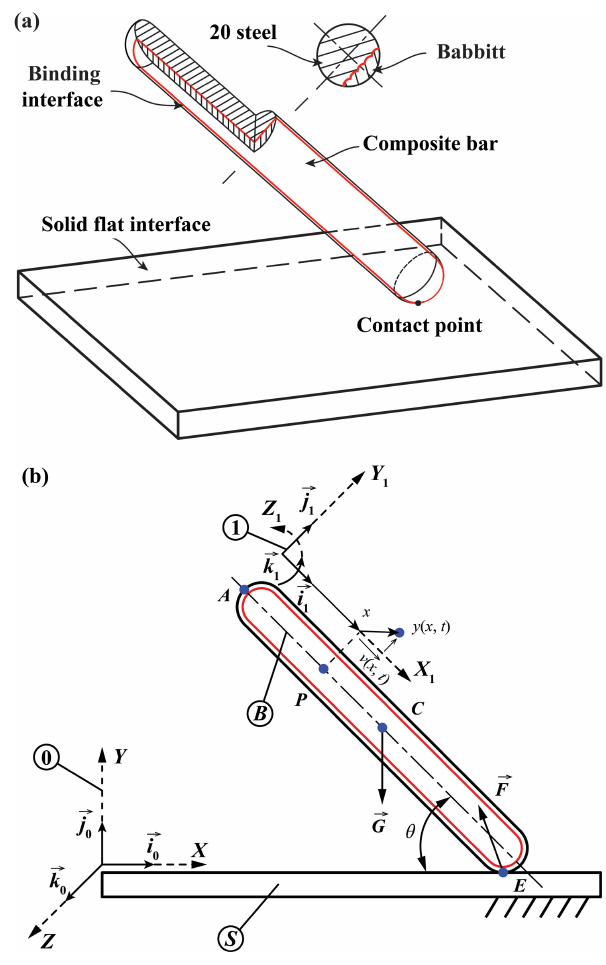
Figure 1. Schematic of the composite structural bar during a contact-impact event: (a) the 3-D view, and (b) the kinematic chain.